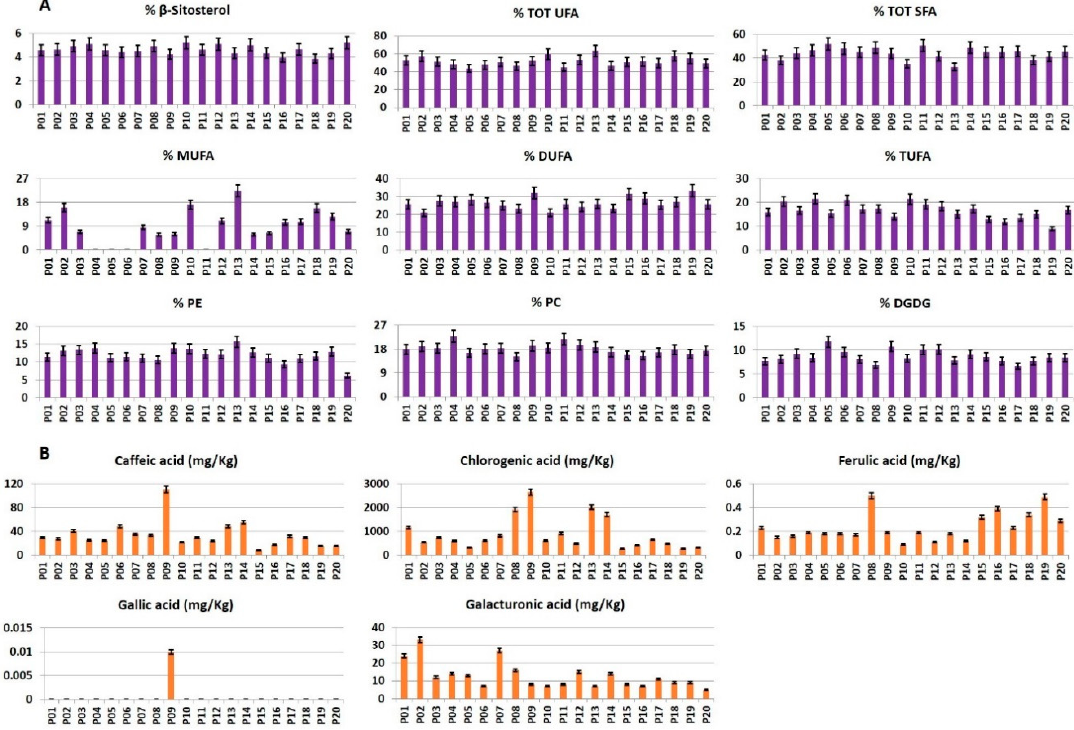
Figure 4. Histograms related to ( A ) compounds identified and quantified (molar % ± SD) in the 1 H NMR spectra of organic Bligh–Dyer extracts and ( B ) compounds identified by RP-HPLC-PDA-ESI-MSn (Reversed Phase High-Performance Liquid Chromatography with Photodiode Array Detector and Electrospray Ionization Mass Detector) in hydroalcoholic extracts (mg / Kg dry weight ± SD) .